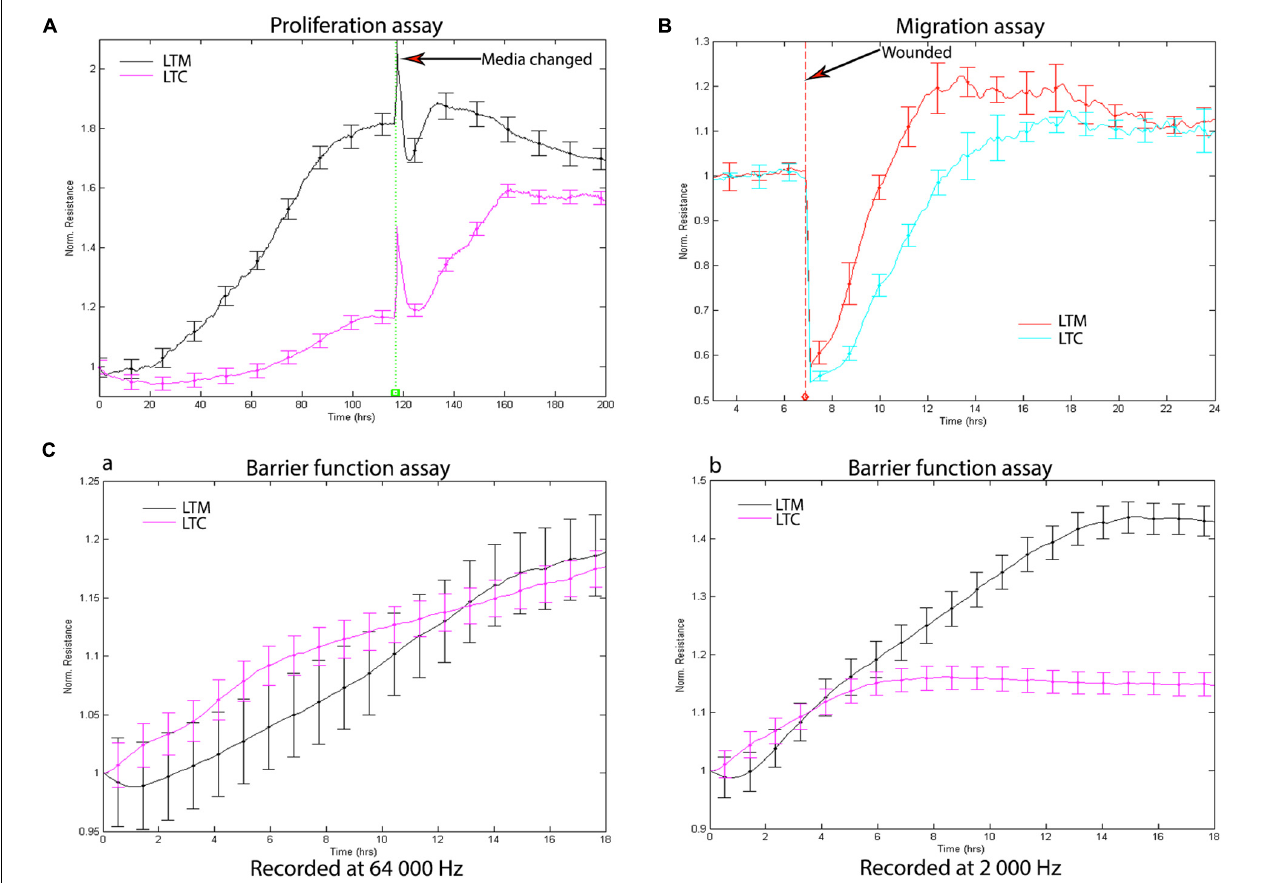
FIGURE 2 | (A) Long-term CSE exposure inhibits Nuli-1 cells proliferation. Media were changed after 118 h. Signals were recorded at 4,000 Hz. Each condition was conducted in triplicate. Statistically differences observed after 24 h ( P < 0.05) (B) Long-term CSE exposure inhibits Nuli-1 cells migration. The resistances were measured at 4,000 Hz. Each condition was conducted in triplicate. Statistically differences observed after 7.5 h ( P < 0.05) (C) Long-term CSE exposure impairs Nuli-1 cells barrier function. a. Resistances were recorded at 64 000 Hz; b. Resistances were recorded at 2,000 Hz. The resistances were measured simultaneously. Each condition was conducted in triplicate. Statistically differences observed after 7 h ( P <